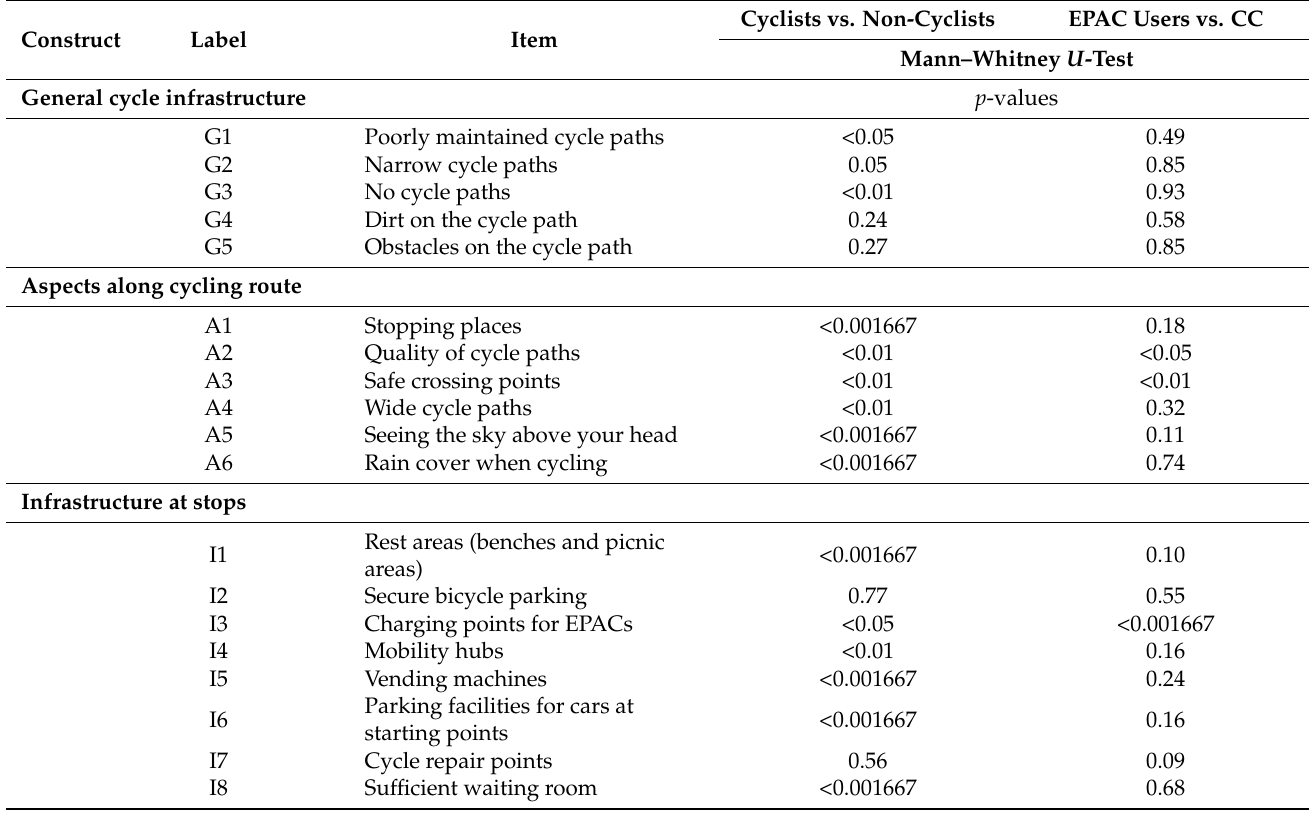
Table 6. Mann–Whitney U-test p -values on item